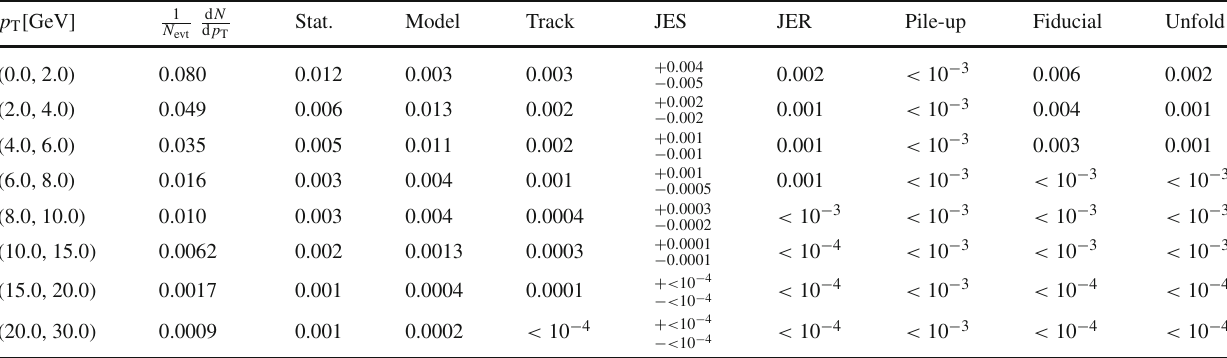
Table 14 Transverse momentum distribution unfolded to the particle level for K 0 with the statistical and systematic uncertainties p T [GeV] Stat. Unfold